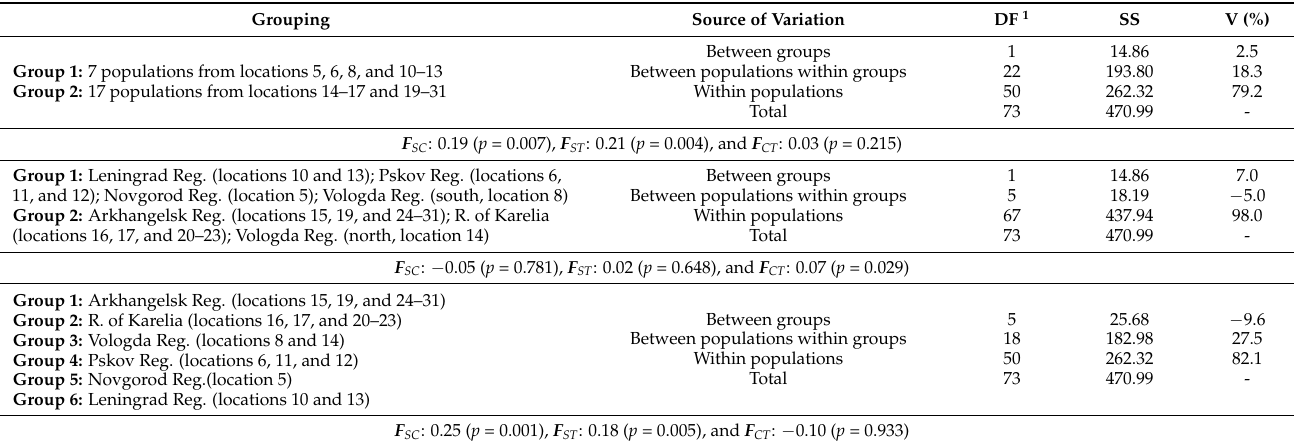
Table 1. Analysis of molecular variance for B. pseudobassiana using MLS data for different grouping variants. Data were partitioned to test the effect of the genetic structure in the Köppen-Geiger climate zones (dfb and dfc) of northern European Russia by population sizes and administrative